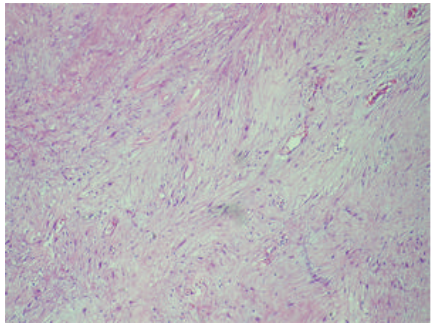
Figure 4: H&E, × 40; Antoni B areas characterized with less cellular, loosely textured Schwann